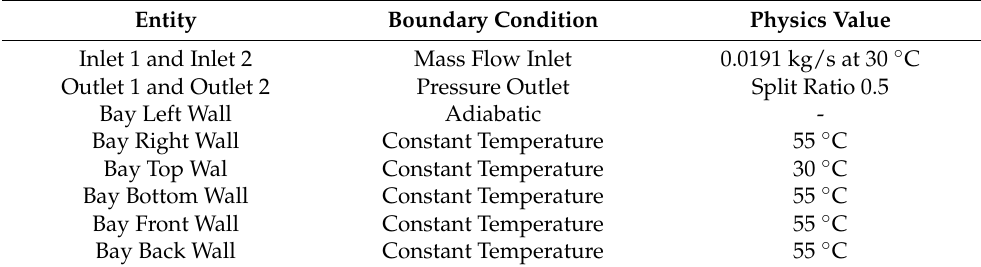
Table 1. Boundary conditions for the cockpit underfloor equipment bay (Configuration 1).